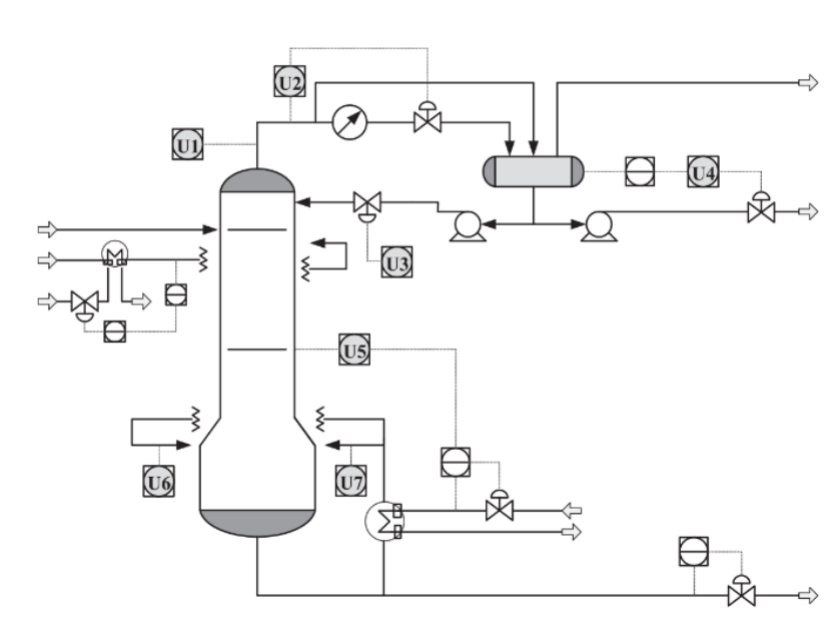
Figure 6. Schematic representation of the debutanizer column process [3]. In real industrial scenarios as chemical process, labeled data is normally limited. From the debutanizer column, a total of 2384 samples were collected, but only 10% of samples denote the labeled set. The 90% of samples left represent the unlabeled dataset. The unsupervised pre-training uses the unlabeled samples as follows: 80% for